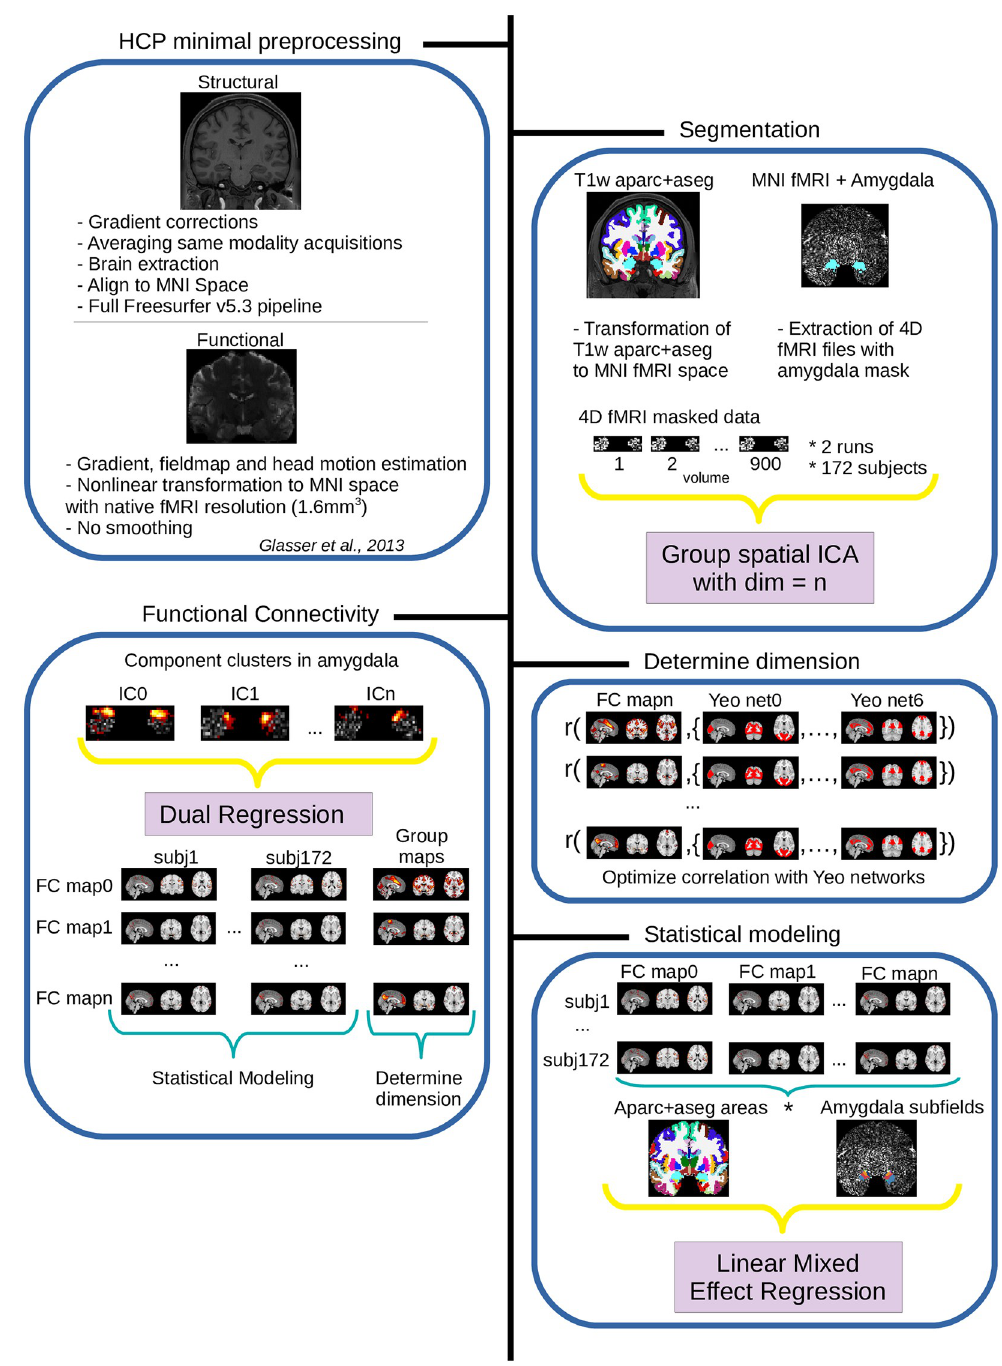
Fig 2. Overview of the analysis pipeline in our data. See text for